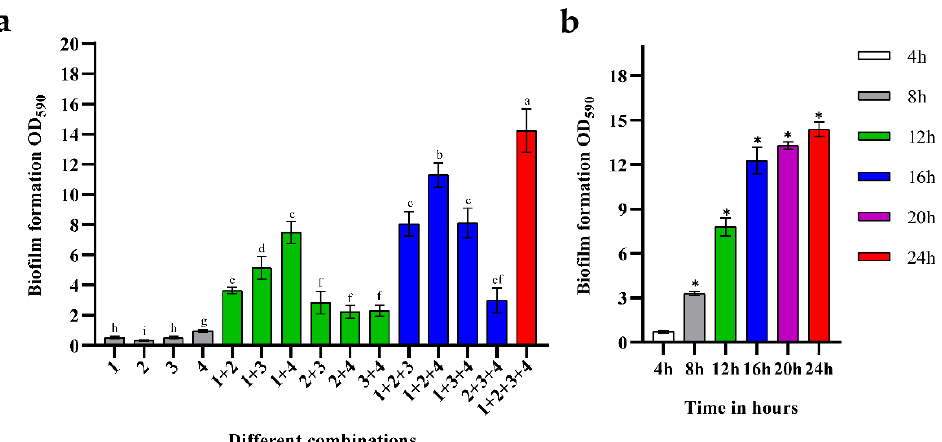
Figure 1. ( a ) Biofilm formation of the four strains. The numbers marked in the histogram represent different strains: 1— B. longum subsp. Infantis FJND16M4, 2— B. ovatus FTJS5K9, 3— L. gasseri FHNFQ11L7, and 4— E. faecalis E1. Lowercase letters above bars represent significant